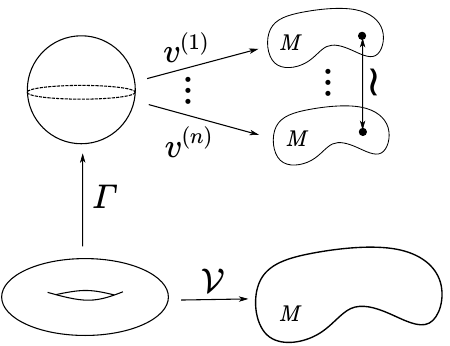
Figure 1 . A sketch of the branched covering approach in orbifold correlator calculations. The fields in the twisted sector are lifted by Γ to a single field on a covering surface Σ . Note that the genus of the covering surface can be higher than that of the original